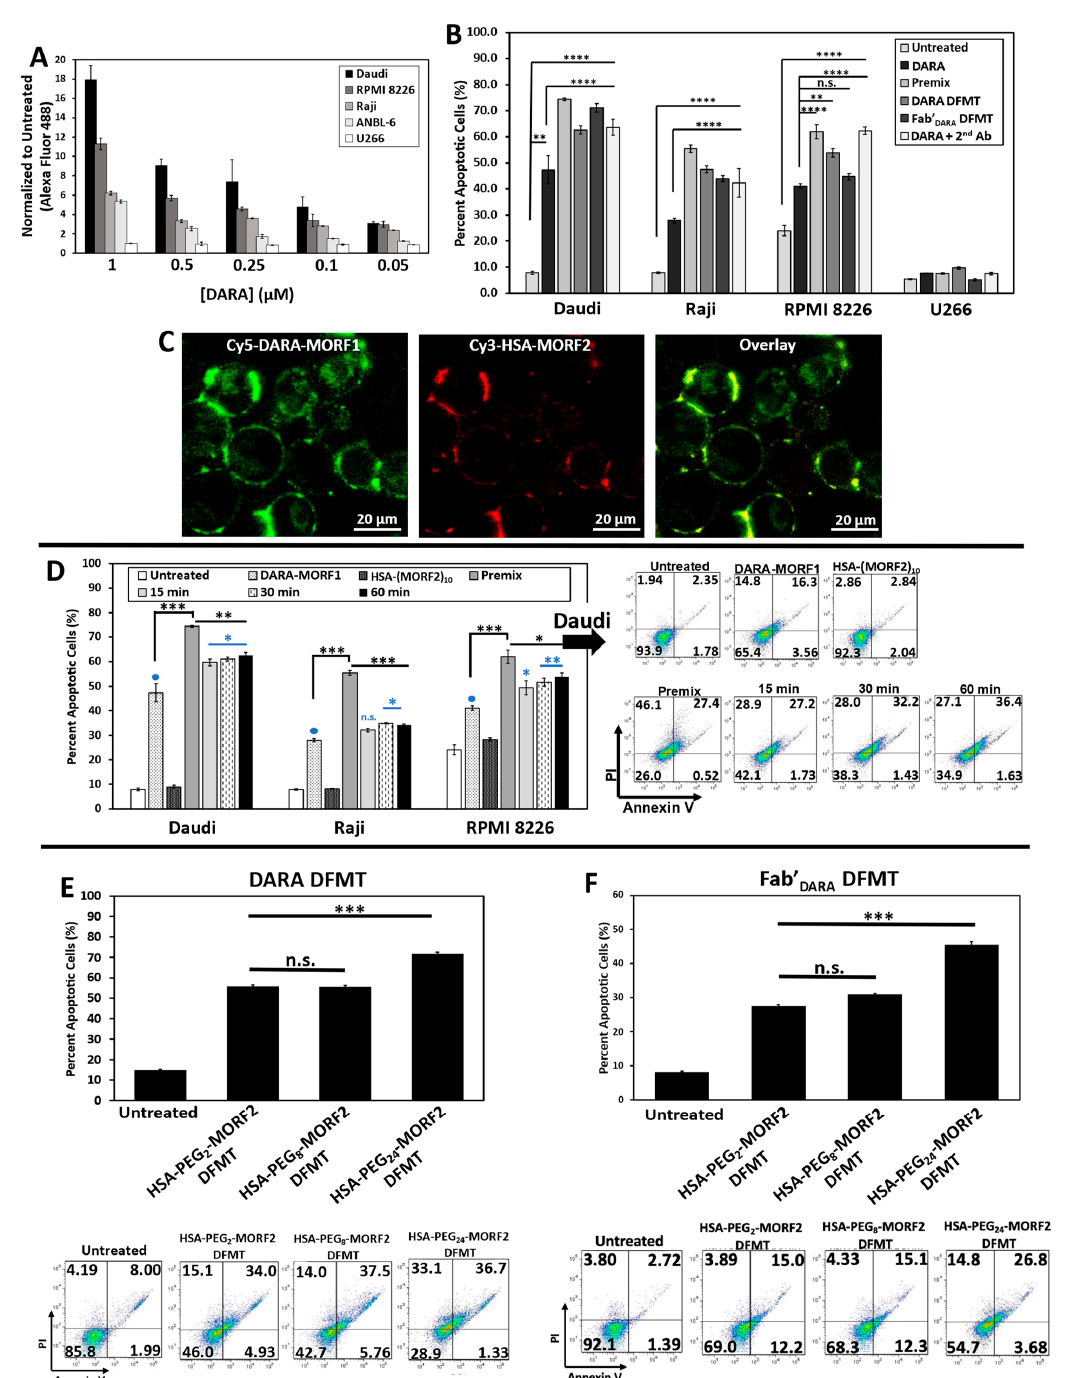
Figure 2. ( A ) DARA binding on various B cell lines as determined by secondary fluorescence of a Fluor 488-labeled anti- human goat antibody. ( B ) Apoptosis induced by DARA-MORF1 and Fab’ Dara -MORF1 DFMT treatments on various CD38+ cell lines and one CD38- cell line: U266. Cell viability was measured by Annexin V and Propidium Iodide staining and analyzed by flow cytometry. ( C ) Confocal microscopy of fluorescently labeled nanoconjugates: Cy5-DARA-MORF1 (left, green); Cy3-HSA-(MORF2) 10 (middle, red); overlay (right, yellow) of Cy5 and Cy3 channels on Daudi cells. ( D ) Effect of time lag (15, 30, and 60 min) between the administration of the bifunctional engager, DARA-MORF1 and the multivalent effector, HSA-(MORF2) 10 on apoptosis initiation. ( E , F ) Effect of HSA PEG linker length on DFMT apoptosis efficacy on Daudi cells. ( E ) DARA-MORF1 + HSA-PEG 2,8,24 -(MORF2) y . ( F ) Fab’ DARA -MORF1 + HSA-PEG 2,8,24 -(MORF2) y . Flow cytometry cell population distribution data for the HSA PEG linker length studies are also shown. All experiments were performed in triplicate. **** p < 0.0001, *** p < 0.001, ** p < 0.01, * p < 0.05, n.s., not significant by One-Way ANOVA and Tukey